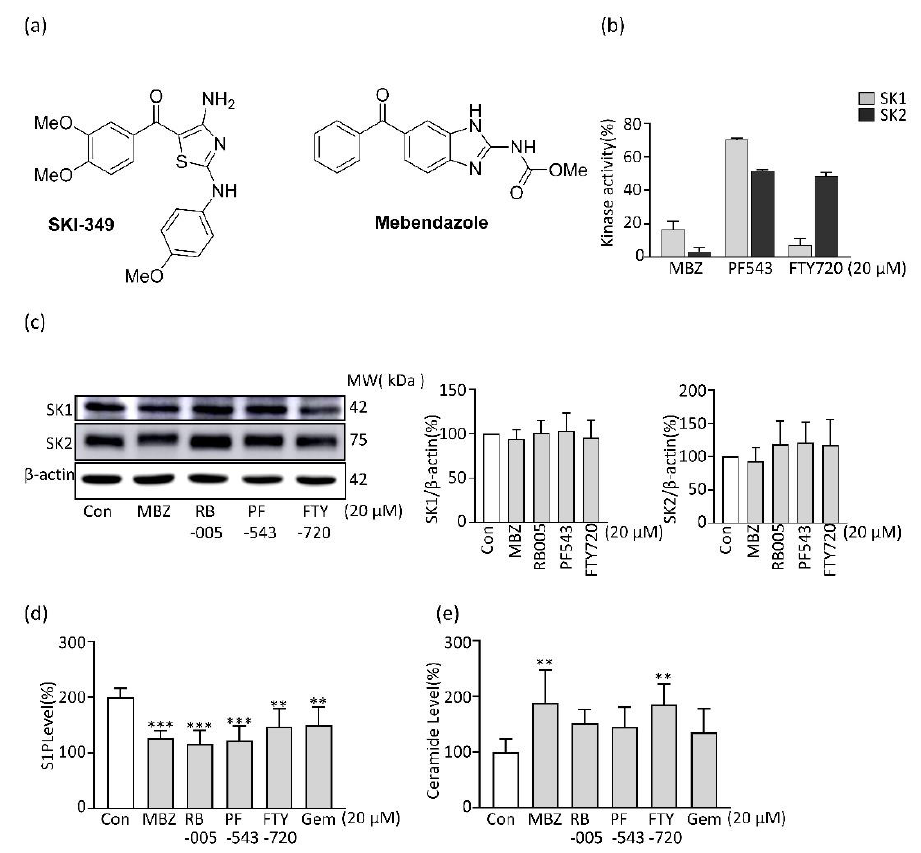
Figure 1. Evaluation of SK activity and sphingolipids of MBZ: ( a ) structure of SKI-349 and MBZ; ( b ) SK1 and SK2 activity of MBZ, PF543 and FTY720 at 20 µM concentrations; ( c ) SK1 and SK2 expression levels of MBZ, RB005, PF543 and FTY720 (20 µM), protein level was normalized with β -actin; results were quantified in a ratio of SK1/β - actin and SK2/β -actin using ImageJ software; ( d , e ) measurement of sphingosine-1-phosphate and ceramide levels in MIA PaCa-2 cells after treatment with 20 µM compounds for 24 h. Each experiment has performed a minimum of thrice and the data were illustrated as mean ± S.D. ** p < 0.01 and *** p < 0.001 compared with the control group.